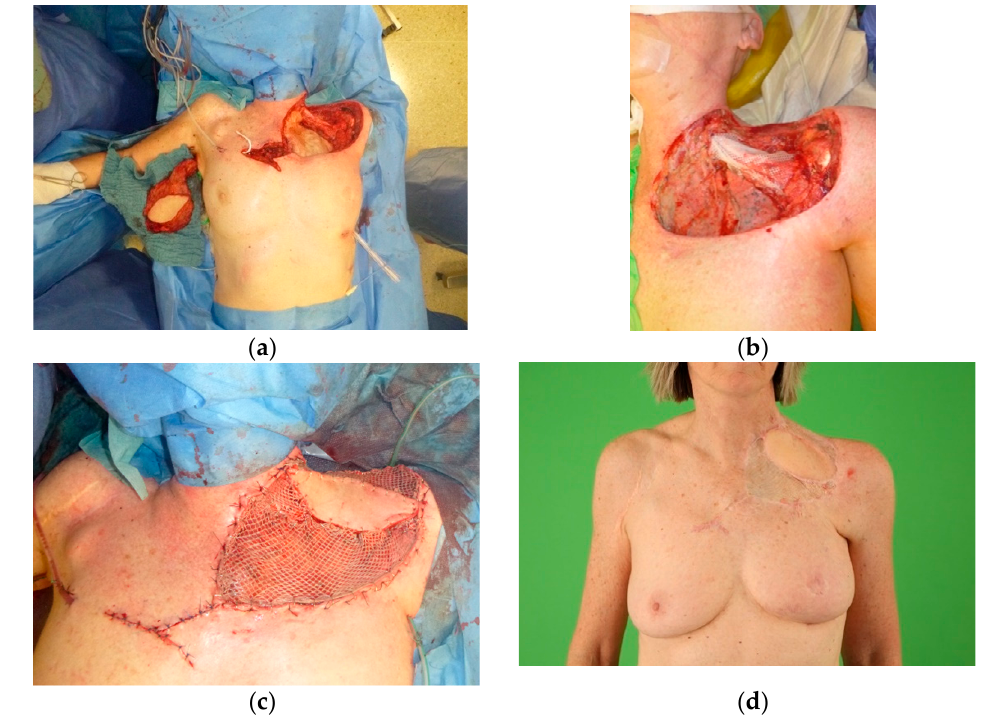
Figure 3. A case of cutaneous angiosarcoma (RIAS) of the left thoracic wall. The patient developed an angiosarcoma after radiation therapy targeting invasive, ductal breast cancer of the left breast. After complete resection of the radiation field including a part of the left clavicle and costa I ( a , b ), a free myocutaneous latissimus dorsi flap was raised and transposed, followed by an end ‐ to ‐ end anastomosis to the right internal mammary artery. Split skin was harvested from the thigh to cover the flap ( c ). Adjuvant chemotherapy (Doxorubicin, Adriamycin and Ifosfamide, and Dacarbazine) was given. After 6 months, the patient presented with a satisfactorily aesthetic and excellent reconstructive result ( d ).